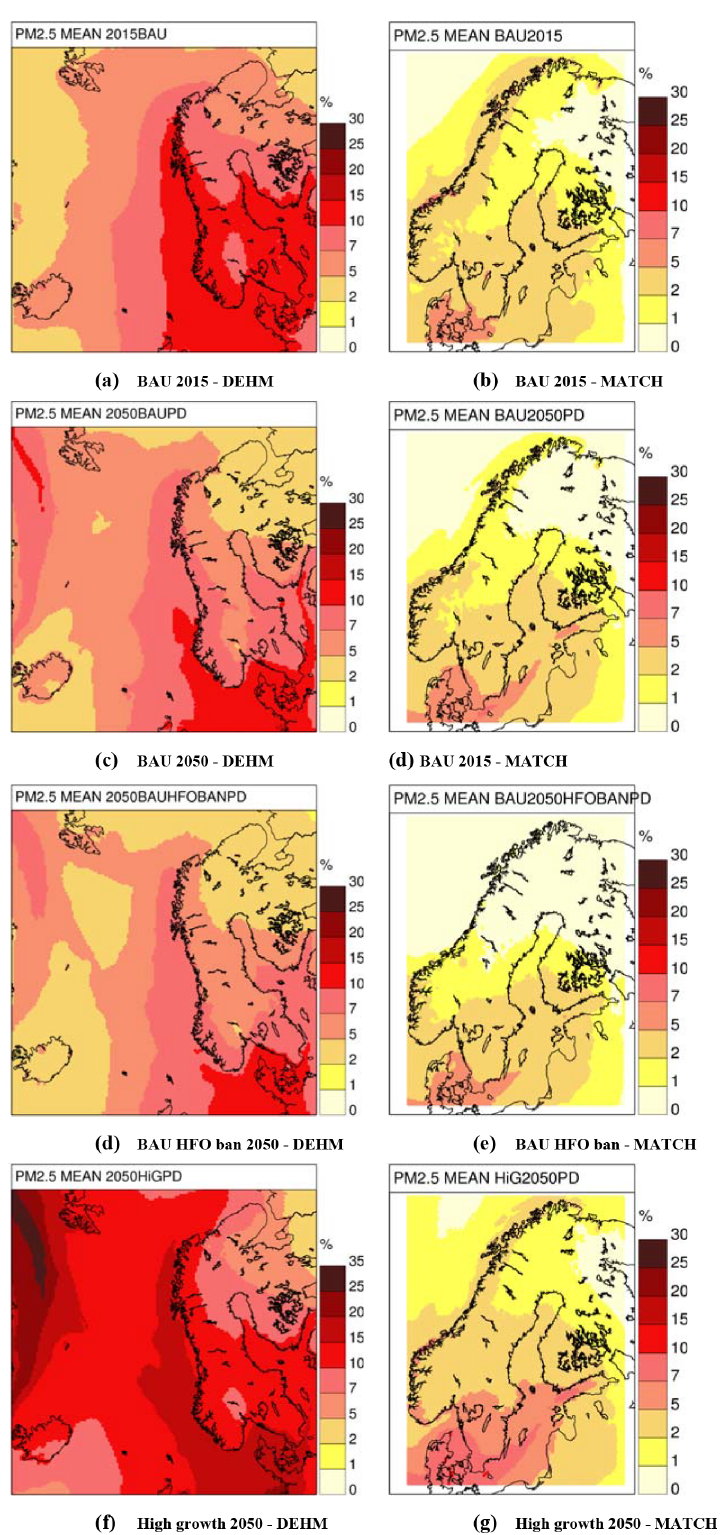
Figure 8. The contribution from shipping to the PM 2 . 5 annual levels as simulated by the two models for the present day and three different shipping emission scenarios for 2050. Calculated using, e.g. (2015BAU − 2015BAU_70% / 0.3) / 2015BAU · 100%, where 2015BAU_70 is a run where the shipping emissions have been reduced to